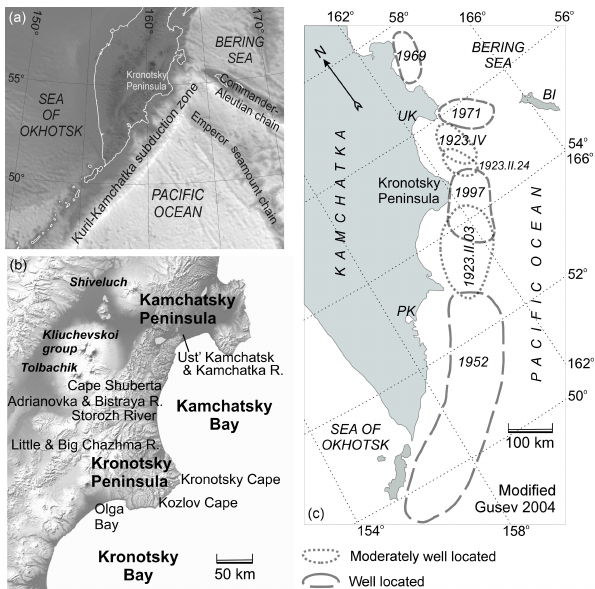
Figure 1. General tectonic setting and study locations. (a) Major topography of and bathymetric features around Kamchatka. (b) lo- cations of sites mentioned in the text and tables. (c) Interpreted rupture locations of 20th century tsunamigenic (except 24 Febru- ary 1923) earthquakes along the Kamchatka portion of the Kuril– Kamchatka subduction zone (modified from Gusev, 2004, Fig. S1; Martin et al., 2008). The rupture area of the 1997 earthquake shown here is from Gusev (2004) and outlines the entire aftershock zone (Fig. 2). Tide-gage locations: PK, Petropavlovsk–Kamchatsky; UK Ust’ Kamchatsk; BI, Bering Island.